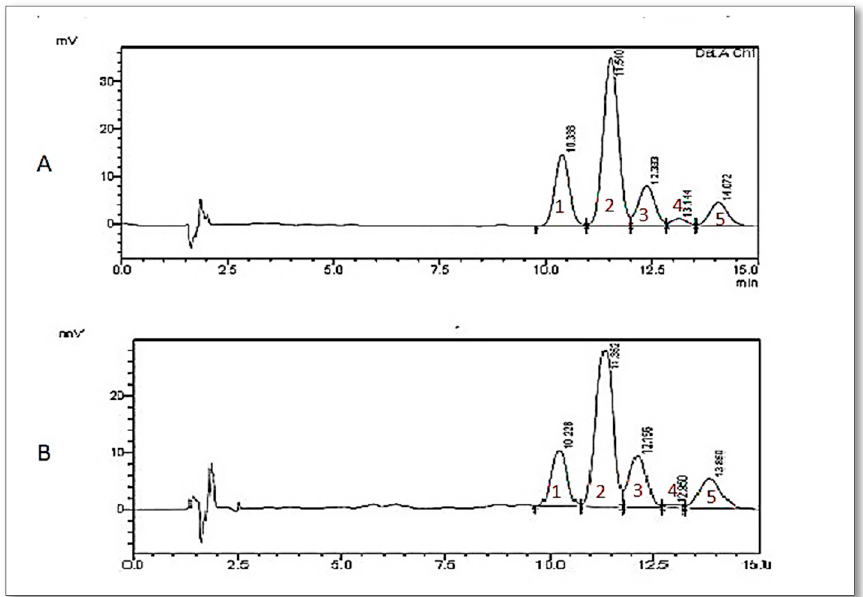
Figure 1. Results of high performance liquid chromatography (HPLC): ( A ) standard gamma oryzanol, and ( B ) gamma oryzanol from Ionic Liquid (IL)-1-Butyl-3-Methylimidazolium Tetrafluoroborate [BMIM]BF 4 -Microwave Assisted Extraction (MAE). Gamma oryzanol compounds include cycloartenyl ferulate (1), 24-methylenecycloartenyl ferulate (2), campesteryl ferulate (3), ∆ 7-cytostenyl ferulate (4) and β -sitosteryl ferulate (5).